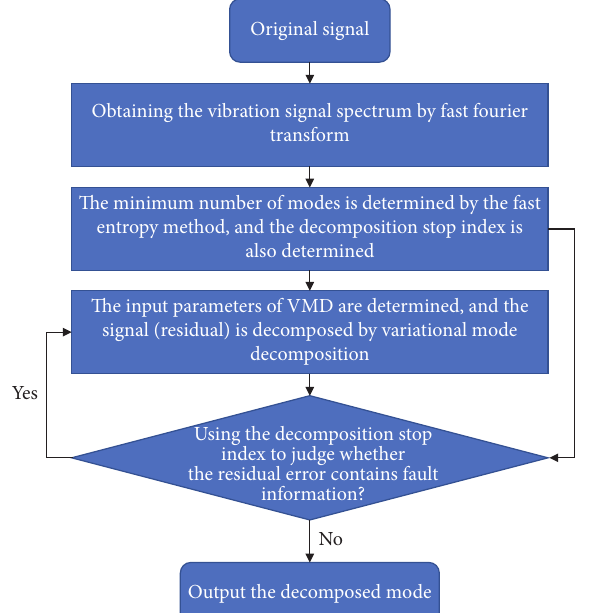
Figure 1: Flowchart of the FE-MVMD method.